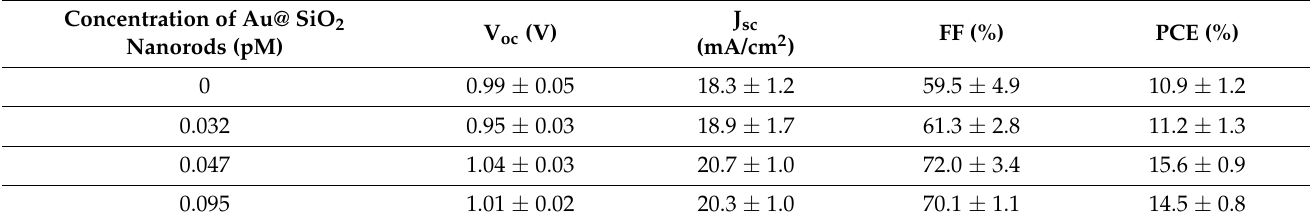
Figure 13. Glass/FTO/Au@TiO 2 nanofibers/MAPbI 3 /. spiro-OMeTAD heterojunction/Au ( left ) with and ( right ) without Au@SiO 2 nanorods. Table 6. With and without Au@SiO 2 nanorods, PHJ-PSC devices developed JV curves showing the average performance parameters. In parentheses, the best photovoltaic parameters are given.